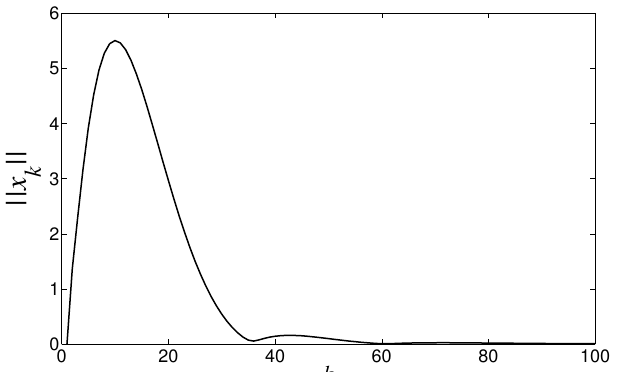
Figure 5. Norm of states for the tunnel diode circuit encountering stealthy DoS jamming attacks when γ =